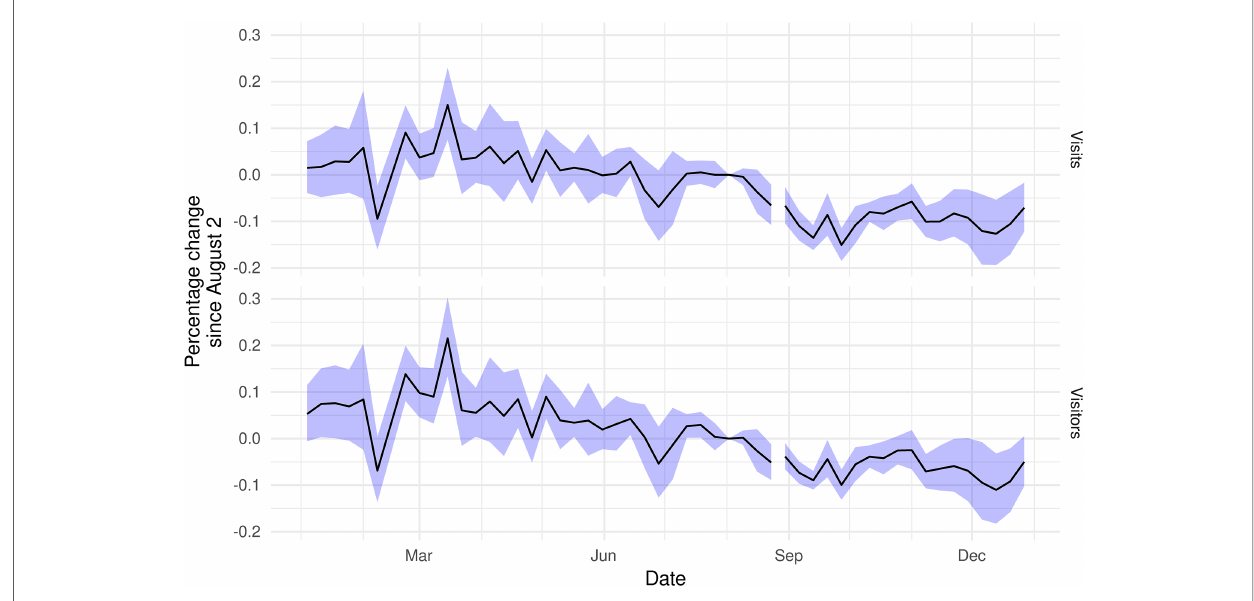
FIGURE 3 Visits (total devices) and visitors (unique devices) to areas near abortion clinics in Texas, relative to clinics in other states and to August 2nd, 2021. Coef fi cient estimates for the interaction of date with an indicator for Texas from two-way fi xed effects Poisson regression, including clinic and date controls. Standard errors are clustered at state level.